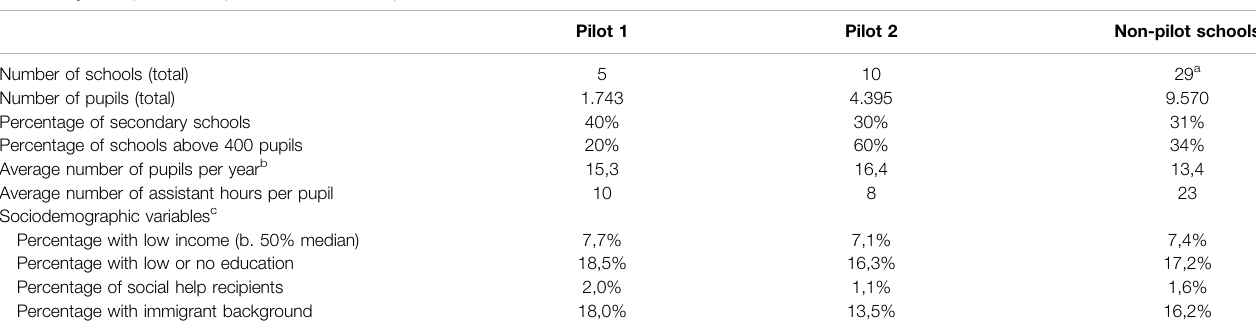
TABLE 1 | Description of the pilot schools and non-pilot